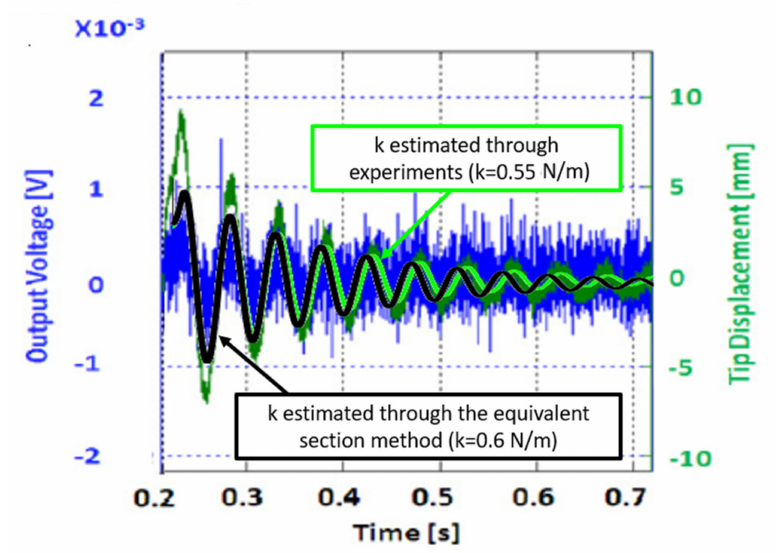
Figure 9. Impulse response: output voltage and tip displacement (both experimentally estimated) as a function of time. The graph includes the impulse response of the BC simulating Equation (1) with an elastic constant of 0.6 N/m (estimate through Equation (2)) and the simulation by using the elastic constant of 0.55 N/m (estimated through experiments).